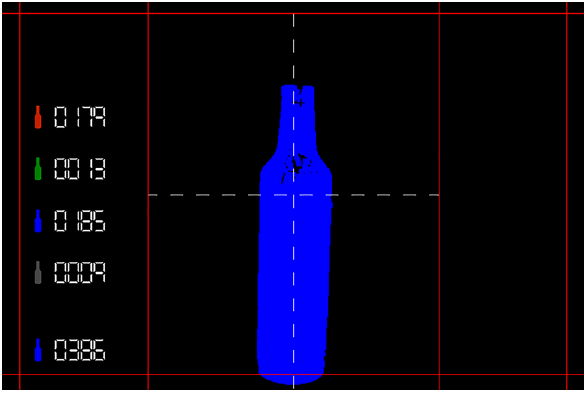
Figure 7. Final image displayed on screen.